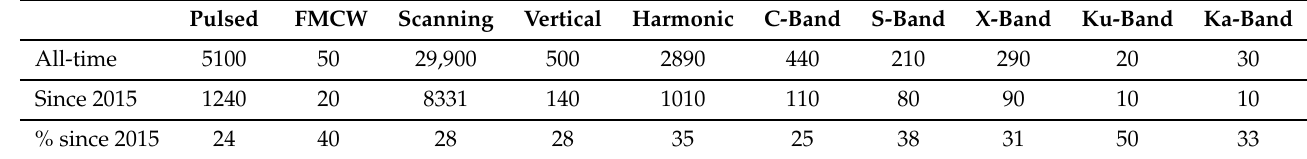
Table 3. Estimated numbers of publication mentioning relevant insect radar